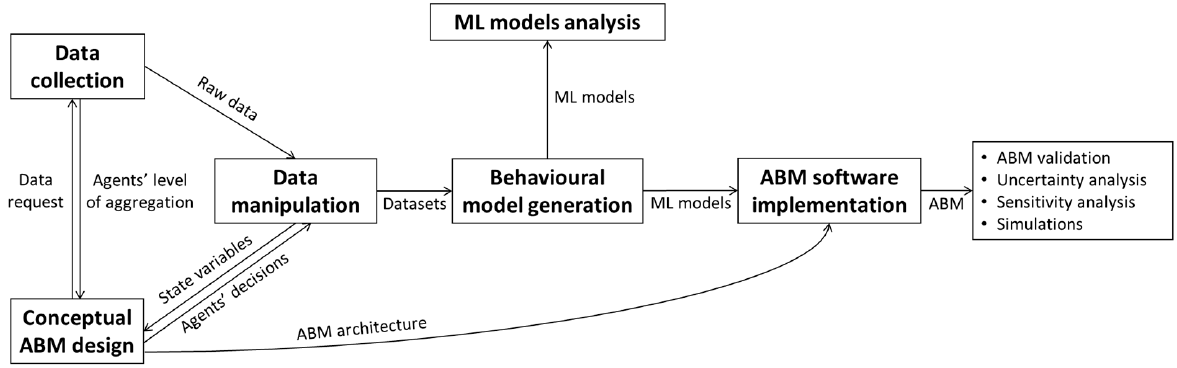
Figure 3. Modelling stages of the data-driven agent-based modelling framework and information elements exchanged among these stages.